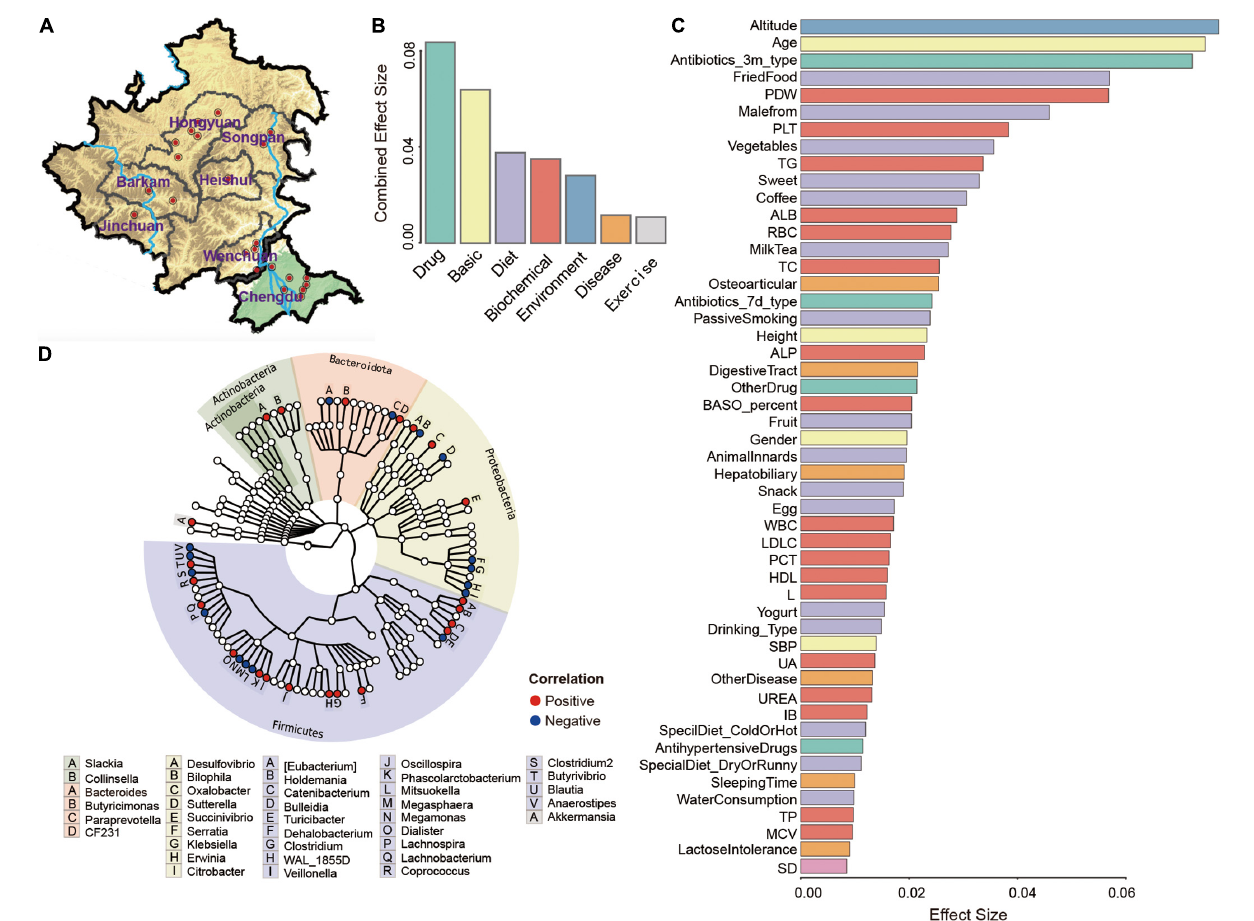
FIGURE 1 | Altitude affects the microbiome of Tibetan ethnicity. (A) Overview of sampling regions in Sichuan province of China. Red dots indicated sampling sites at different regions, blue lines represented Dadu River (left) and Min River (right). Effect size of seven categories (B) and top 50 factors (C) found to significantly influence Tibetan gut microbiota were displayed. Factors were sorted by effect size and colored by seven categories (Basic, Environment, Disease, Diet, Biochemical, Exercise, and Drug). (D) Taxonomic tree of 38 genera with significant correlations (adjusted P < 0.1) with altitude, as determined using